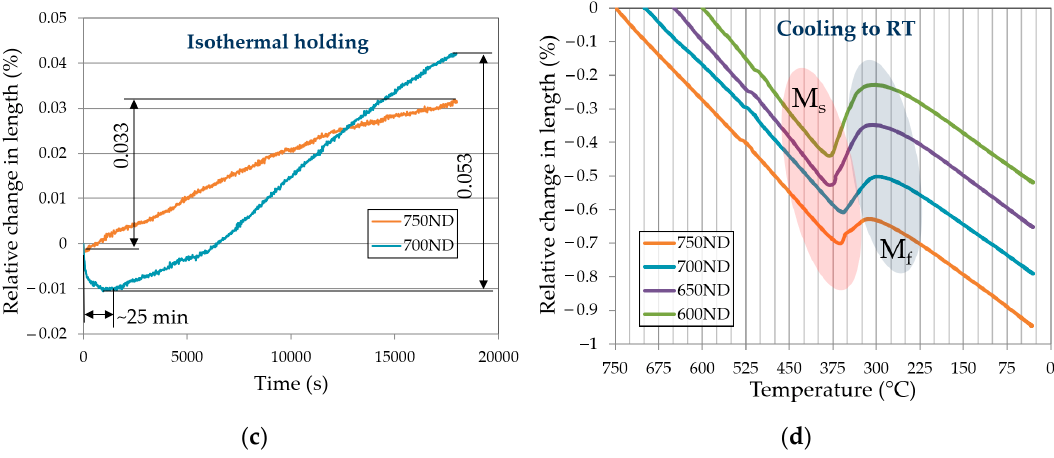
Figure 3. Dilatometric curves of non-deformed samples: ( a ) cooling from the austenitization to isothermal holding; ( b ) isothermal holding step for all non-deformed samples; ( c ) isothermal holding step for samples 700ND and 750ND—exhibiting the ferritic transformation; ( d ) cooling to room temperature showing a range of martensitic transformation; RT—room temperature.